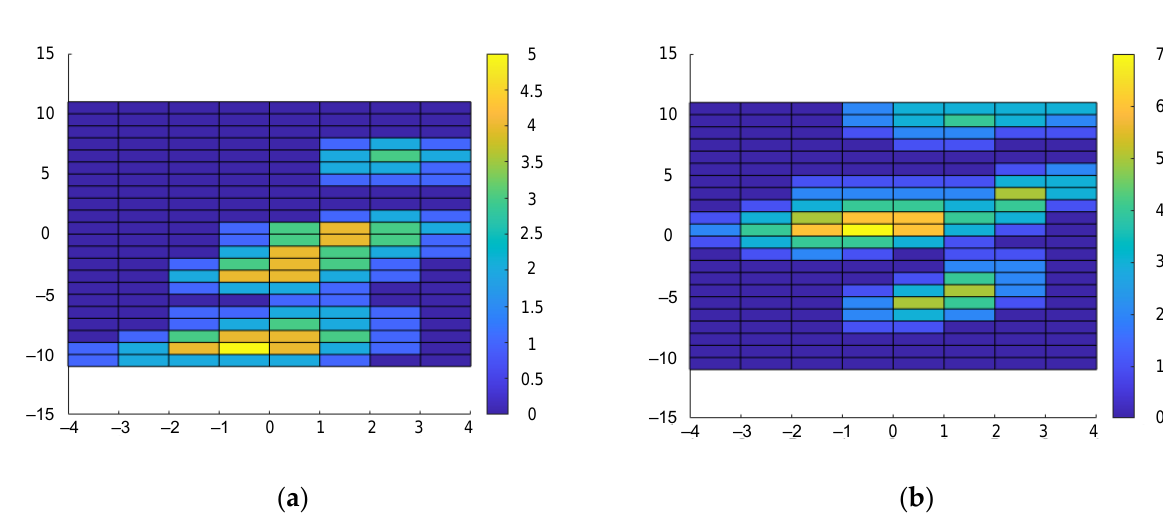
Figure 24. Surface plot of the bi-dimensional cross-correlation of the gait map from Table 7 to the physiological gait map template from Table 4 for ( a ) heel walking, and ( b ) toe walking.